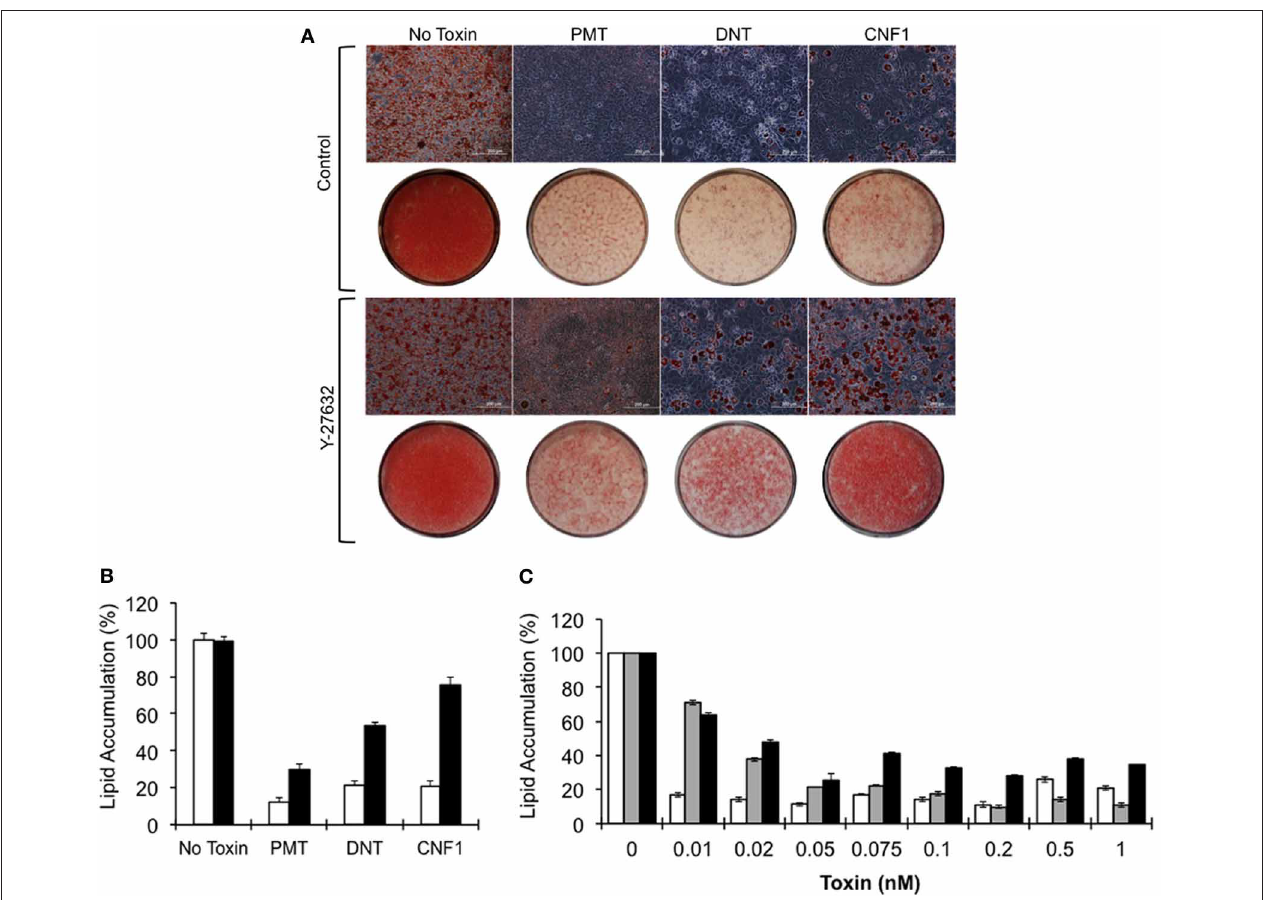
FIGURE 2 | Blockade of 3T3-L1 cell differentiation and lipid accumulation by dermonecrotic toxins. Confluent 3T3-L1 cells were induced to differentiate in DM in the absence or presence of 0.5nM of the indicated toxin, as described in Materials and Methods. (A) Phase-contrast images of Oil Red O-stained 3T3-L1 cells on day 7 after induction of differentiation in the absence (top panels) or presence (bottom panels) of 10 μ M Y-27632. Bar, 200 μ m. Red color indicates Oil Red O staining of lipid droplets. Below each